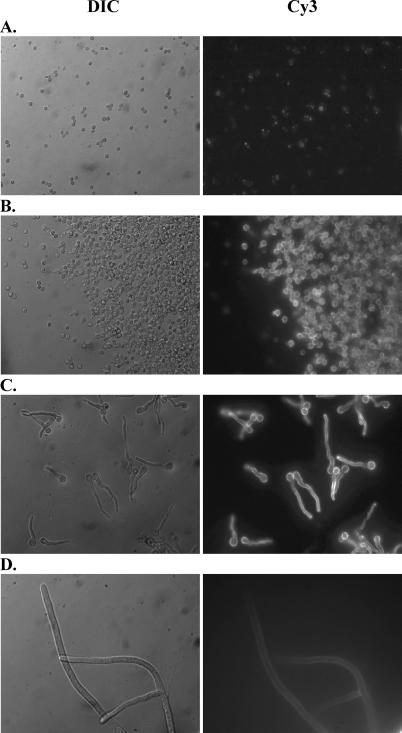
Heightened Binding of Dectin-1 to A. fumigatus SCA soluble fusion protein consisting of the extracellular carbohydrate recognition domain of dectin-1 fused with the Fc portion of murine IgG1 (s-dectin-mFc) was constructed and incubated with live A. fumigatus RC and SC. Binding of s-dectin-mFc was detected by Cy3-conjugated, goat anti-mouse IgG antibody followed by imaging with a Zeiss Axioplan 2 upright fluorescent deconvolution microscope (Zeiss), and images were captured using 3i Slidebook Version 4.0 software (Optical Analysis). Representative micrographs show s-dectin-mFc binding to A. fumigatus grown for 2 h (A), 6 h (B), 10 h (C), and 24 h (D). Left lane images are differential interference contrast (DIC) images, and right lane images are Cy3 staining. Magnification is 630 × oil emersion for all frames.